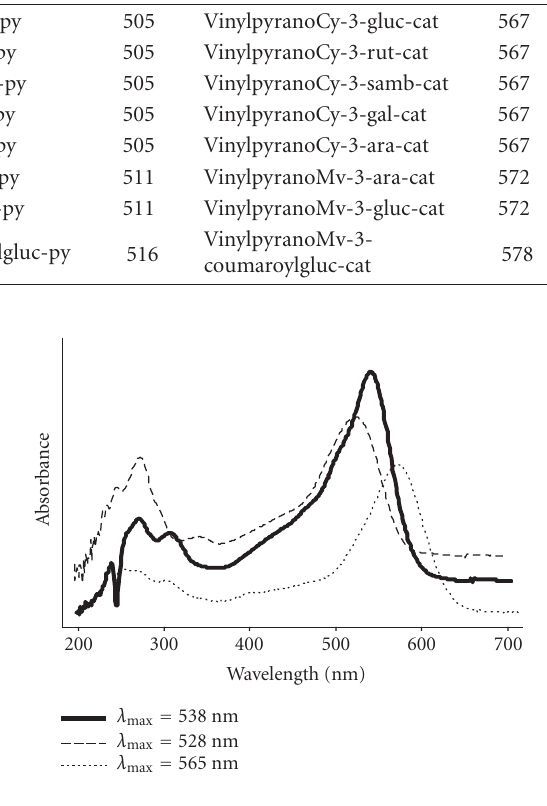
Figure 4. (a) UV-Vis spectra of malvidin 3-O-glucoside (solid), (b) vinylpyranoMv-3-gluc-phenol (dashed), and (c) vinylpyranoMv-3-gluc-phloroglucinol (dotted) recorded from the HPLC diode array detector (pH = 1 . 5).